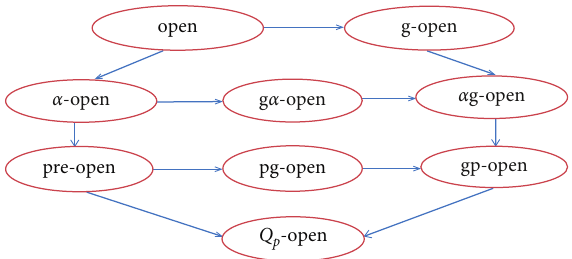
Figure 2: The relationship among the Q